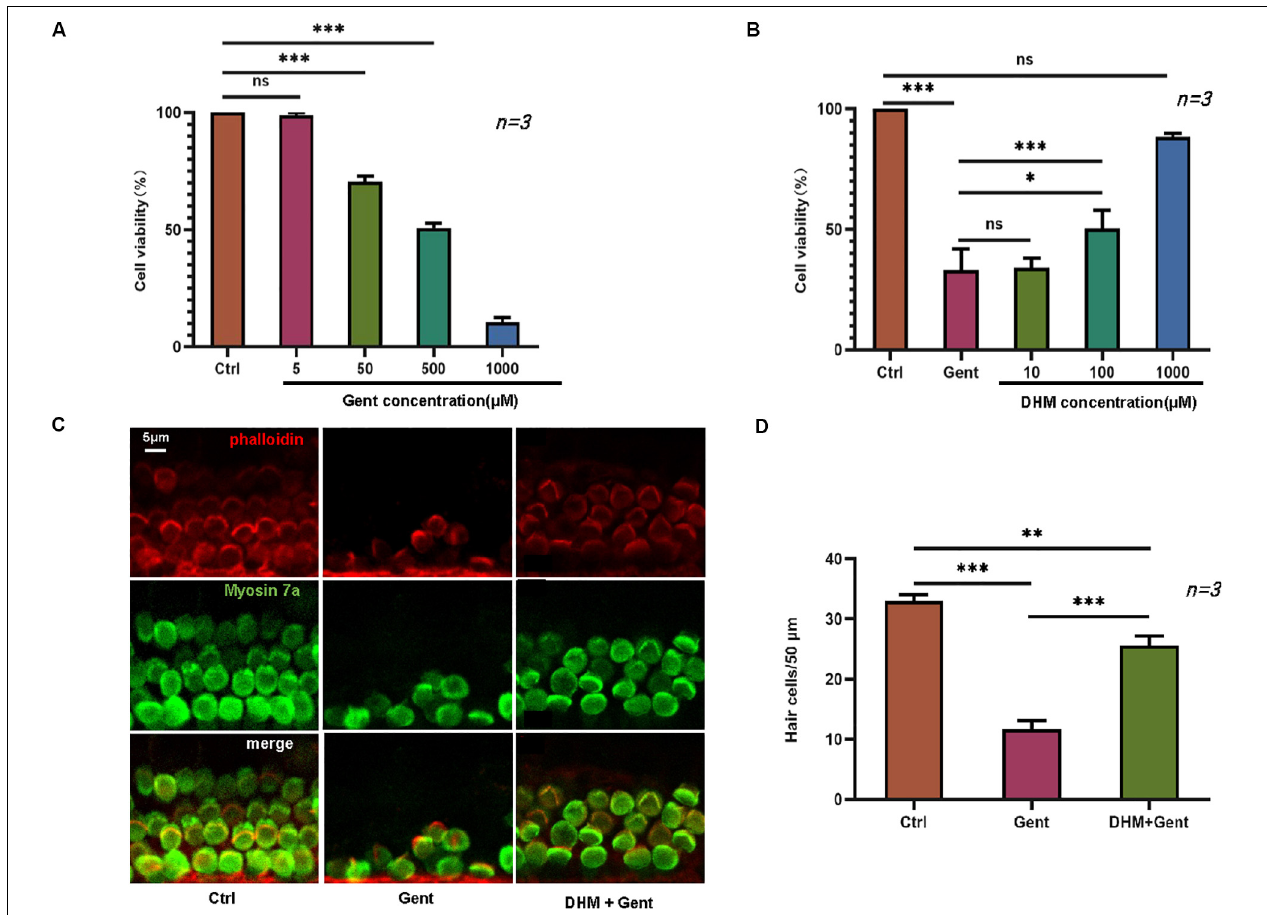
FIGURE 1 | DHM protects against gentamicin-induced ototoxicity in HEI-OC1 cells and cochlear explants. (A) HEI-OC1 cells treated with increasing concentrations of gentamicin (0, 5, 50, and 500 µ M) for 12 h. (B) Effect of DHM pretreatment at 0, 10, 100, and 1,000 µ M for 24 h on the survival of HEI-OC1 cells exposed to 500 µ M gentamicin, measured with the MTT assay. (C,D) Cochlear explants were divided into three groups: Ctrl (no treatment), Gent (no treatment for 24 h and 500 µ M gentamicin for 12 h), and DHM + Gent (1 mM DHM pretreatment for 24 h and 500 µ M gentamicin for 12 h). Samples were labeled with myosin VIIa (green) and phalloidin (red); merged images obtained by confocal microscopy are shown. Scale bar, 5 µ m. Experiments were repeated three times. NS, not significant; ∗ P < 0.05, ∗∗ P < 0.01, ∗∗∗ P < 0.001 (one-way analysis of variance followed by Tukey’s multiple comparisons test).